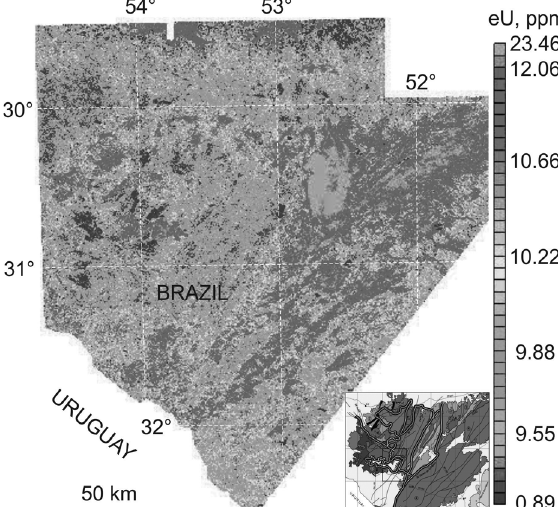
Figure 8 - Map of eU signal over the Sul-Riograndense Shield. For interpretation of the references to color in this figure legend, the reader is referred to the web version of this article.